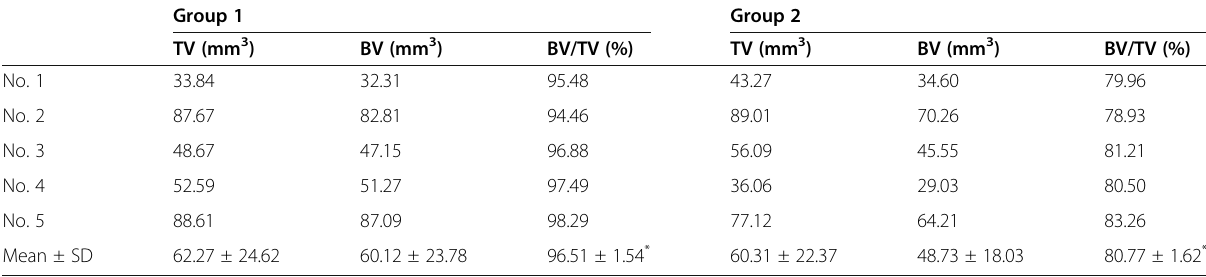
Table 2 Volume measurements in groups 1 and 2 using